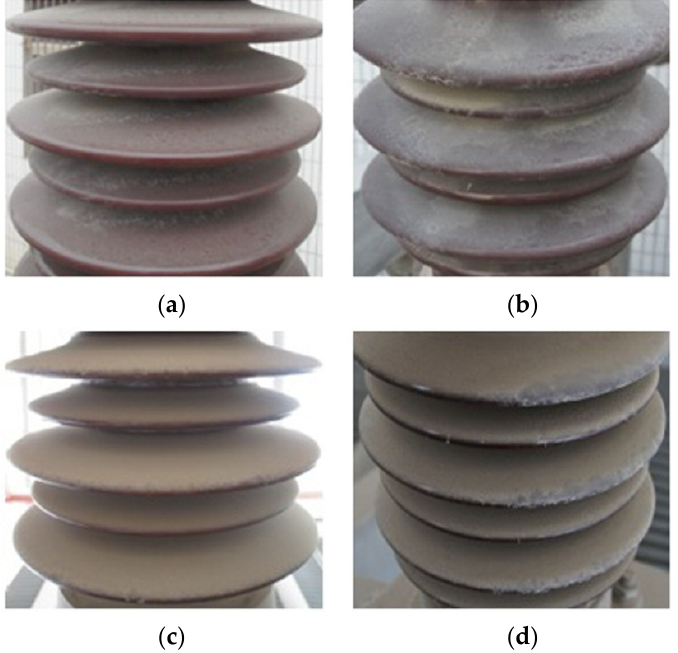
Figure 4. Insulators with different contamination grades: ( a ) contaminated insulator of grade Ⅰ ; ( b ) contaminated insulator of grade Ⅱ ; ( c ) contaminated insulator of grade Ⅲ ; ( d ) contaminated insulator of grade Ⅳ .